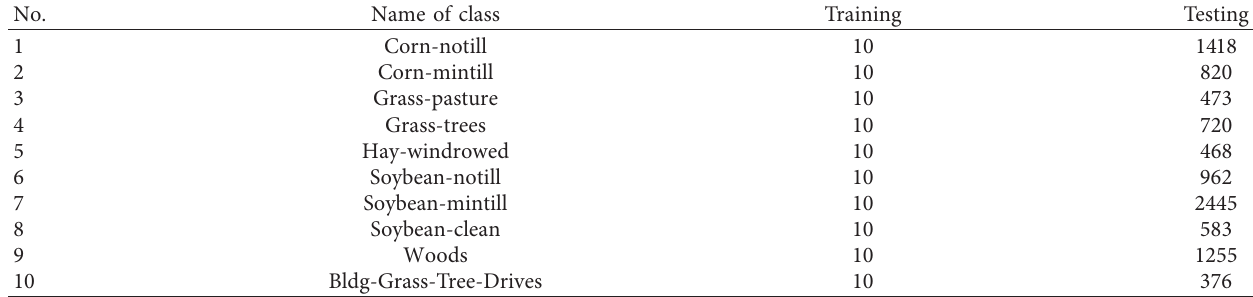
Table 2: The ground truth classes and their respective training and testing numbers of the Indian Pines datasets (10 classes). No.